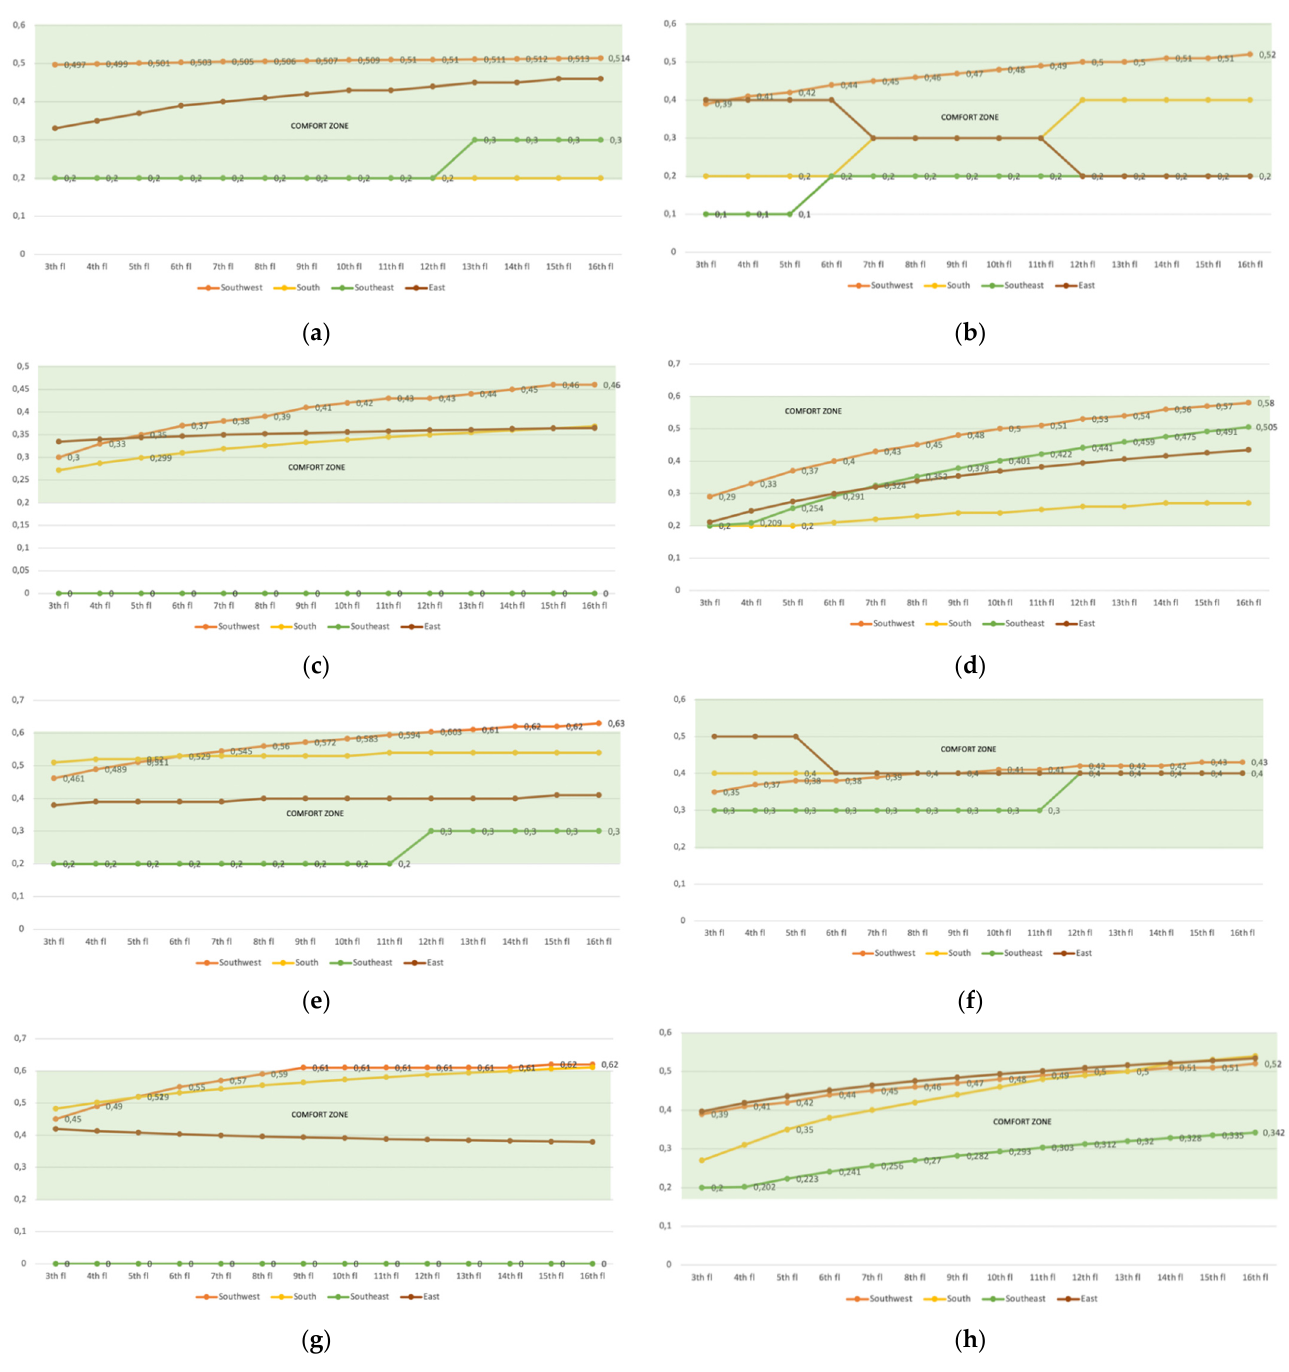
Figure 12. Second-phase data interpolation results: ( a ) unit 1—tower A; ( b ) unit 2—tower A; ( c ) unit 3—tower A; ( d ) unit 4—tower A; ( e ) unit 1—tower B; ( f ) unit 2—tower B; ( g ) unit 3—tower B; ( h ) unit 4—tower B.